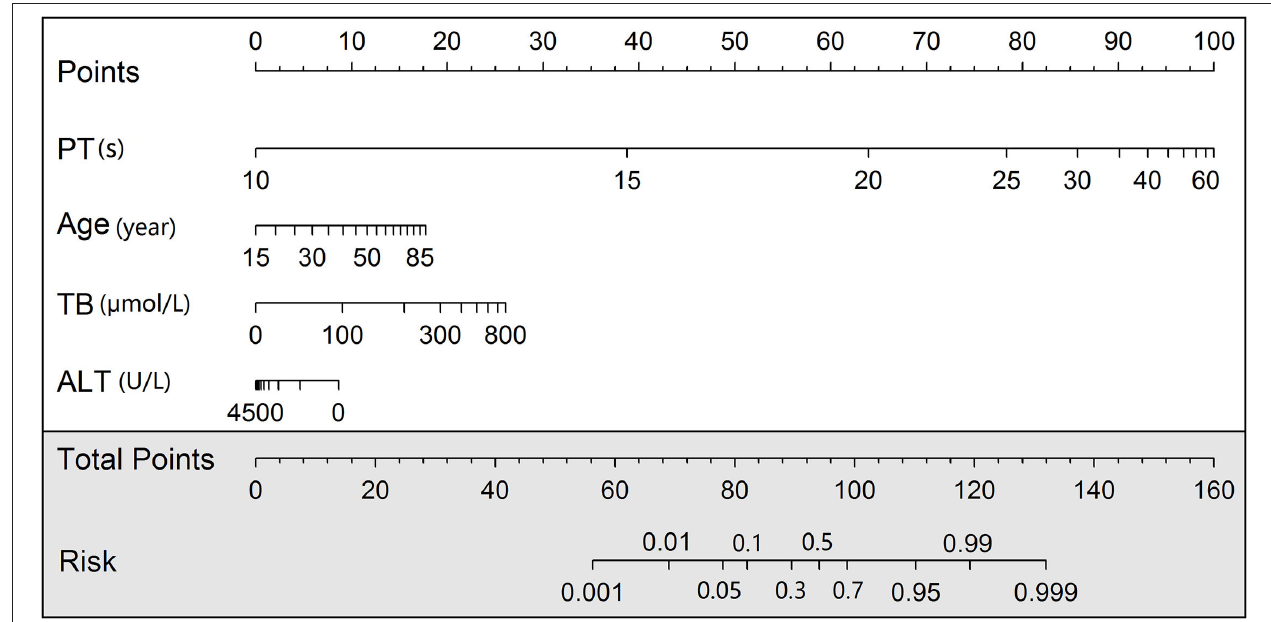
FIGURE 4 | Nomogram for development set.prothrombin time (PT), Tbil, alanine aminotransferase